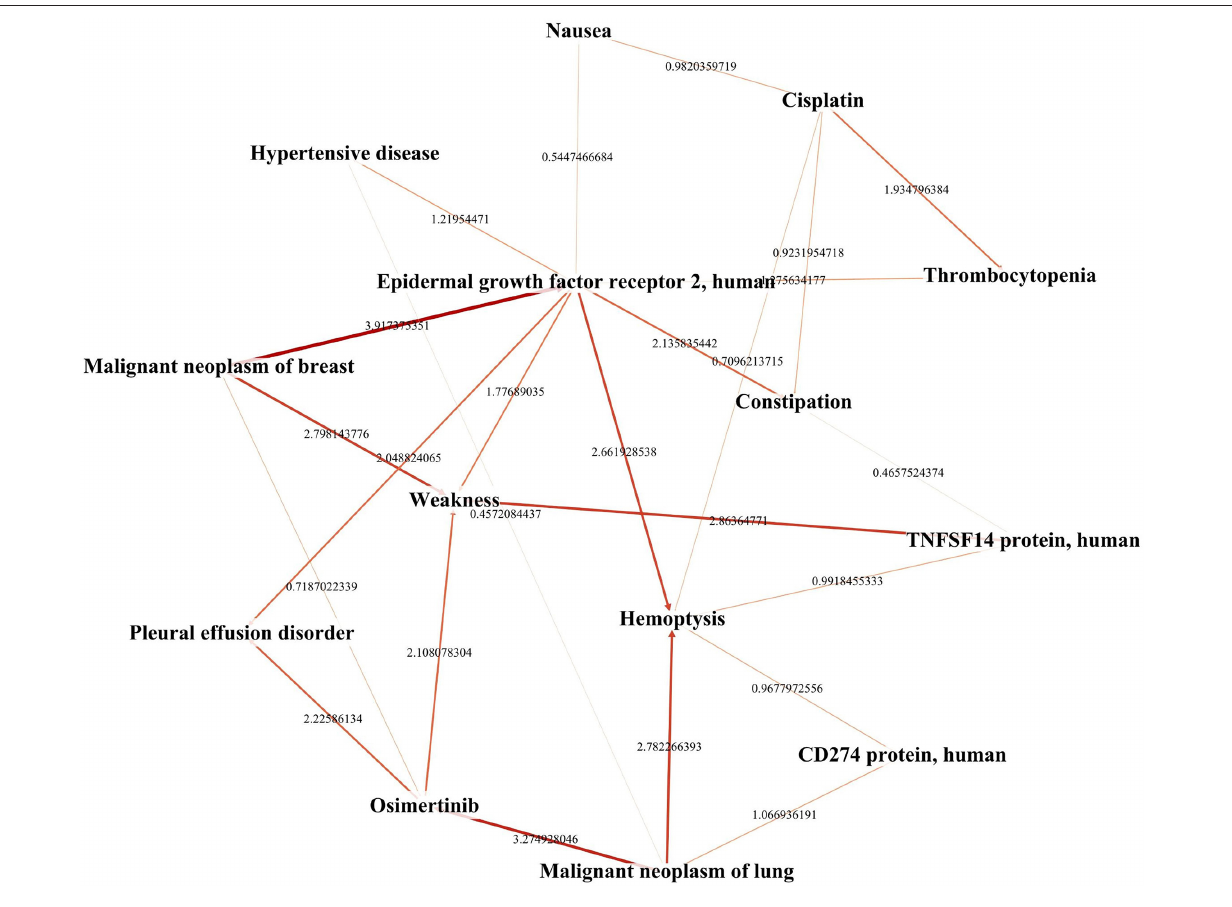
FIGURE 4 | A portion of the network extracted from